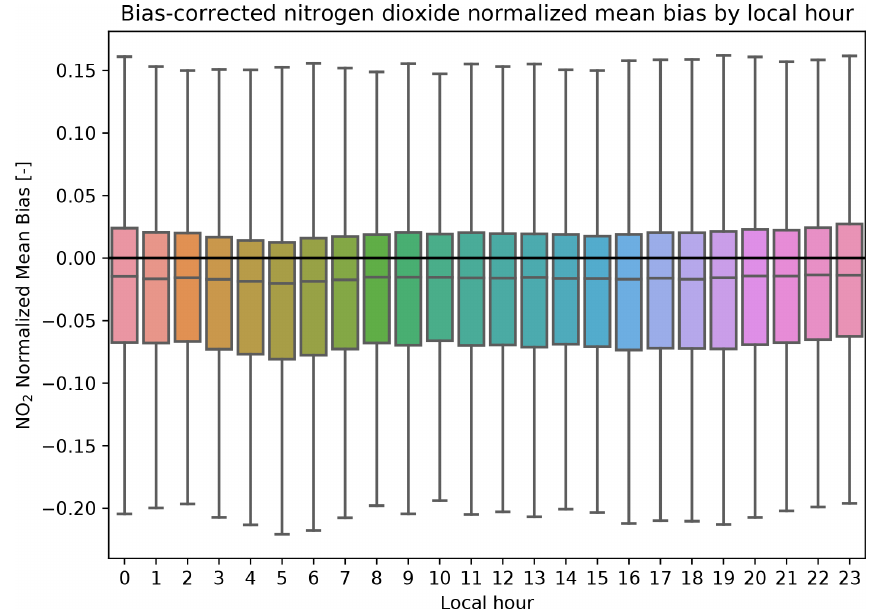
Figure A12. Distribution of normalized mean bias of the machine-learning-corrected nitrogen dioxide concentrations at all available obser- vation sites as a function of local hour. Shown are the results for the test dataset.